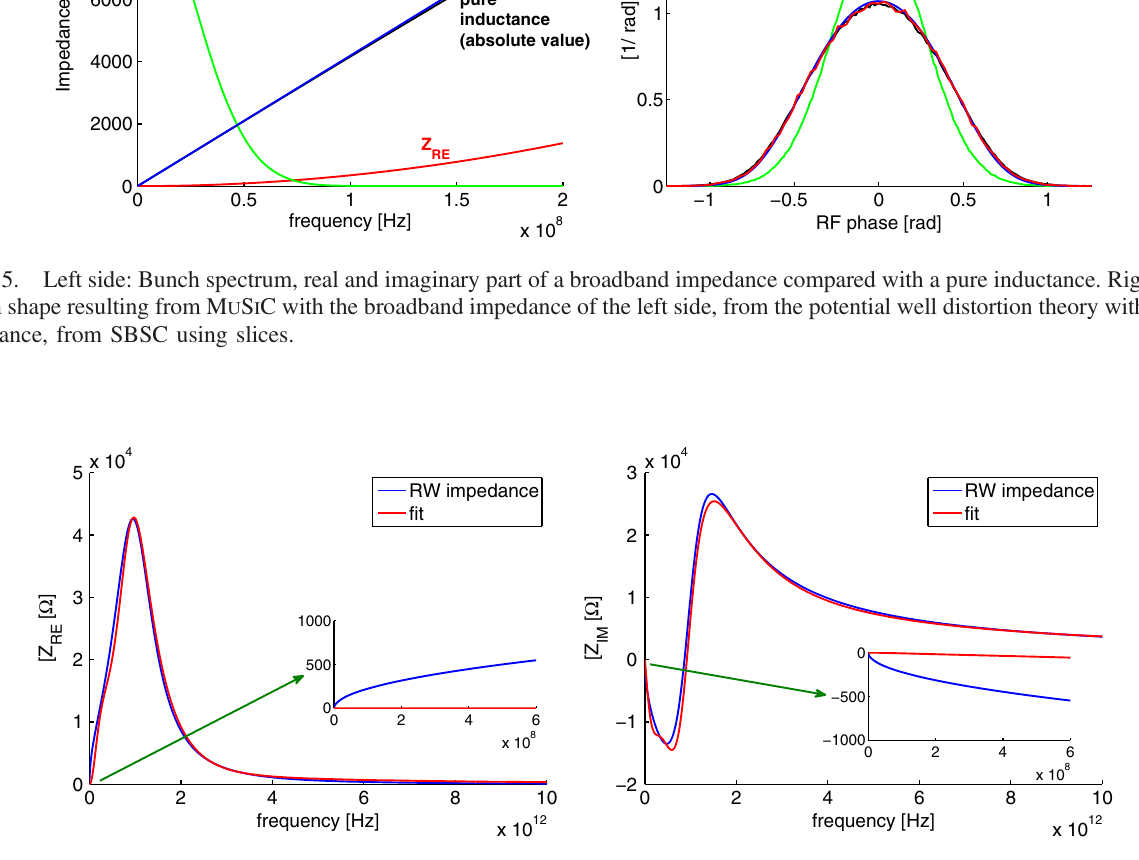
FIG. 16. Real (left side) and imaginary (right side) part of the longitudinal resistive wall impedance compared with a fit of four resonant modes. The zoomed part of the plots shows the low frequency